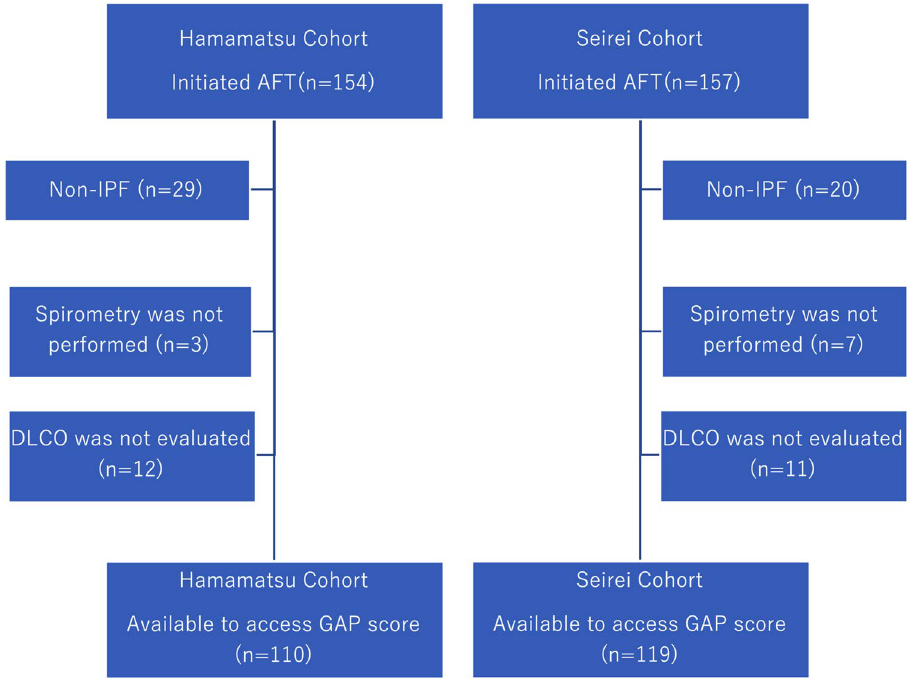
Figure 1. Flow diagram of patient selection. AFT antifibrotic therapy, IPF idiopathic pulmonary fibrosis, DLCO diffuse capacity of the lung for carbon monoxide.